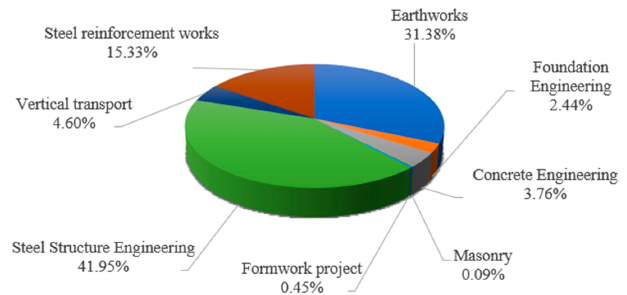
Figure 3. Composition of energy consumption of terminal building division project.